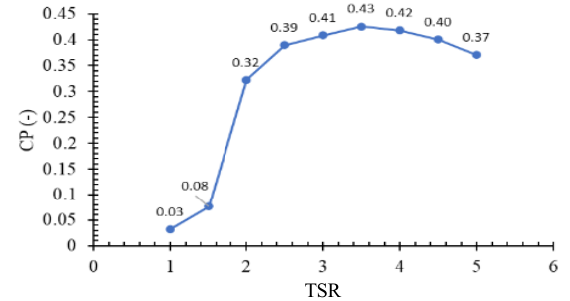
Figure 8. Velocity field around turbine ( V = 2 m/s, TSR = 3.5).